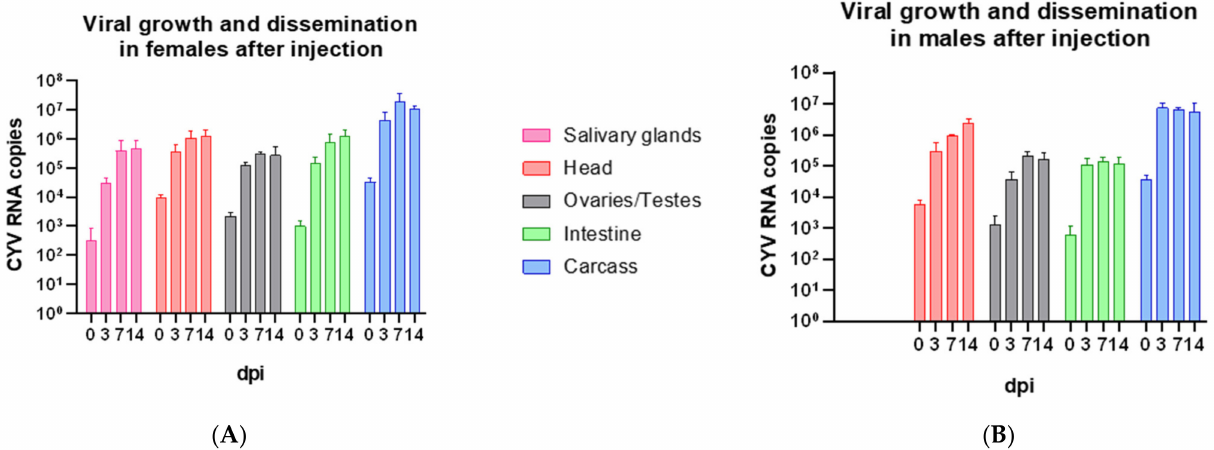
Figure 1. Growth kinetics of CYV after injection in Cx. pipiens biotype molestus . Mosquito dissection and preparation of different organs at zero dpi, three dpi, seven dpi, and fourteen dpi. Mean RNA copy numbers per organ per individual are displayed per dissection day with SD. ( A ) Viral growth in organs of 72 females; ( B ) viral growth in organs of 72 males. Pink—salivary glands; red—head; grey—ovaries/testes; green—intestine; blue—carcass; dpi = days